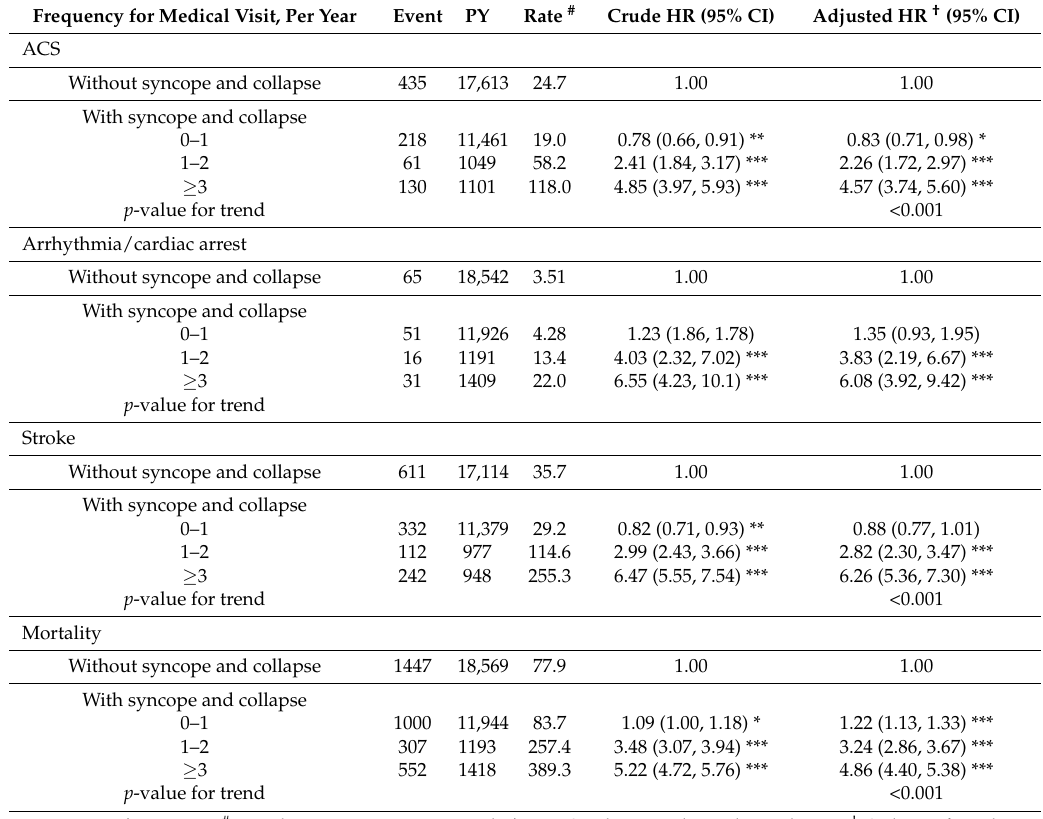
Table 4. Risks of ACS, arrhythmia or cardiac arrest, stroke, and mortality among patients with SC based on frequency of medical visits for SC in Cox proportional hazard